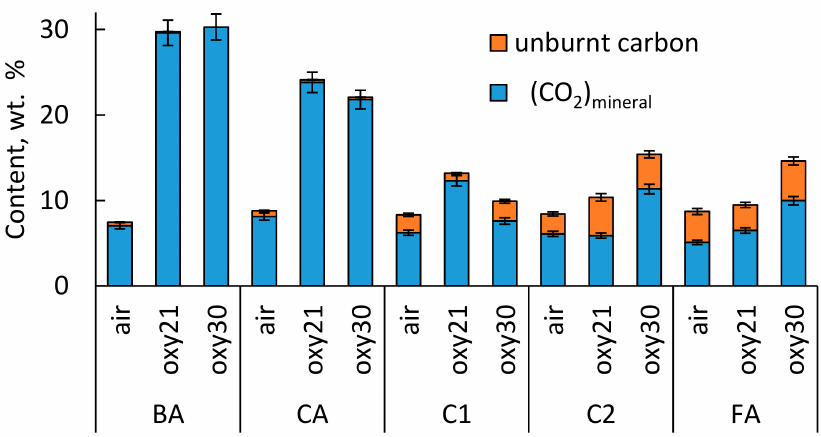
Figure 4. Mineral CO 2 ((CO 2 ) mineral ) and unburnt carbon content in the CFB combustion ashes. Table 5. Chemical composition of oil shale air and oxy-fuel firing carbon free ashes, wt %.